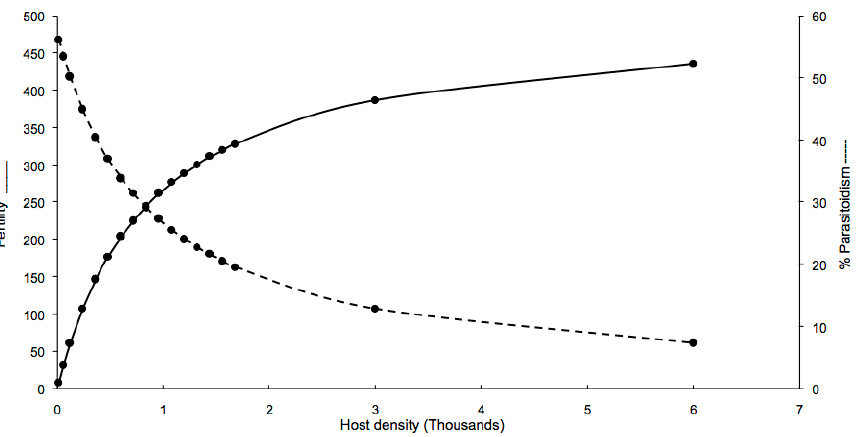
Figure 3. Functional response curve fit by non-linear least-squares regression of Aganaspis daci mated females parasitizing Ceratitis capitata larvae and sharing the experimental unit with Pseudoophonus rufipes adults attacking C. capitata larvae (type II). Host density: 5, 20 or 40 larvae per A. daci mated female and P. rufipes adult (both species sharing the same experimental